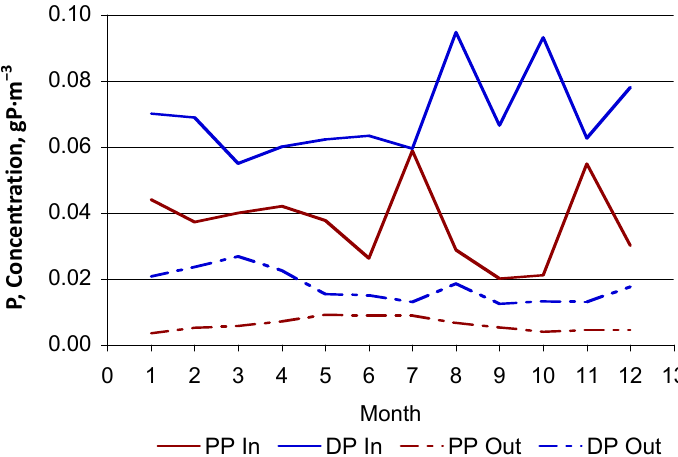
Figure 6. Monthly performance of the ENRP over a four-year POR. The average hydraulic loading was 2.4 cm/day. PP (particulate) and Dissolved phosphorus (DP) are reduced in all months. Overall TP reduction is slightly less in the first six months of the year (73%) and slightly greater in the second six months (82%).